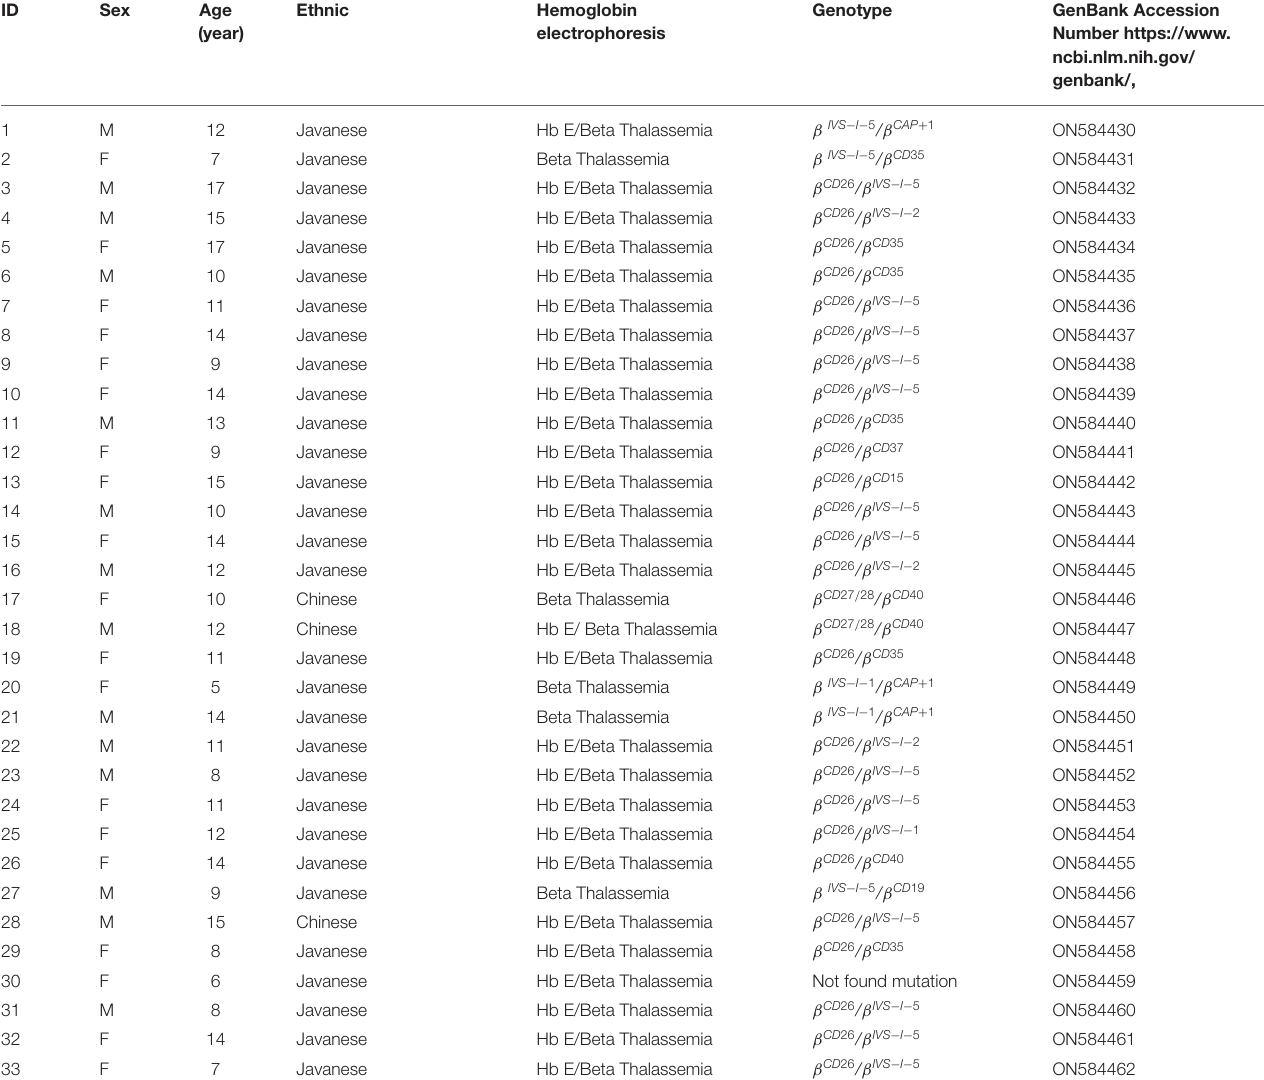
TABLE 4 | Biodata, ethnicity groups, and results of hemoglobin electrophoresis, genotyping of β -thalassemia gene, and GenBank accession number in all 33 patients. ID Sex Age Ethnic Hemoglobin Genotype GenBank Accession (year) electrophoresis Number